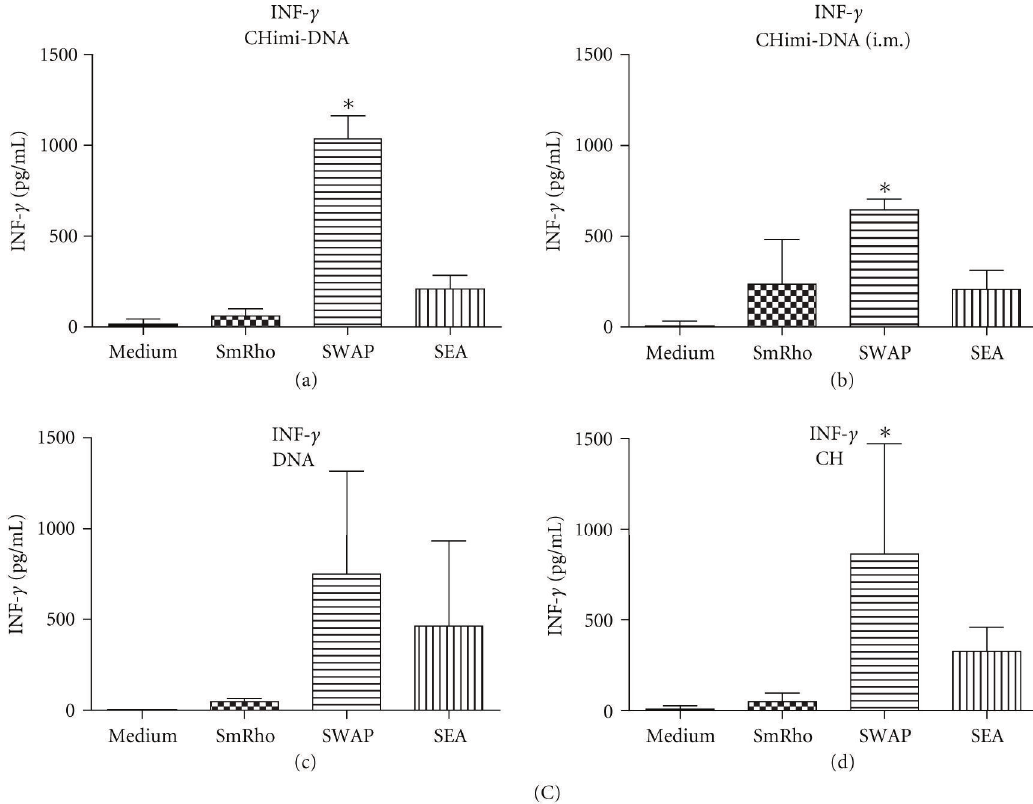
Figure 5: Cytokine profiles of mice immunized with CH-DNA nanoparticles. Splenocytes isolated from mice immunized with Chimi-DNA nanoparticles (a), CHimi-DNA (i.m.) (b), DNA (c), or CH (d) were assayed as IL-10 (A), IL-4 (B) and INF- γ (C), production in response to in vitro stimulation with SWAP (25 μ g/mL), rSmRho (25 μ g/mL), SEA (25 μ g/mL), or medium alone as control. Results represent the mean ± SD of each group. ∗ Statistically significant di ff erences between cytokines produced after SWAP, rSmRho, or SEA stimulation compared with unstimulated splenocytes (control) ( P < 0 .